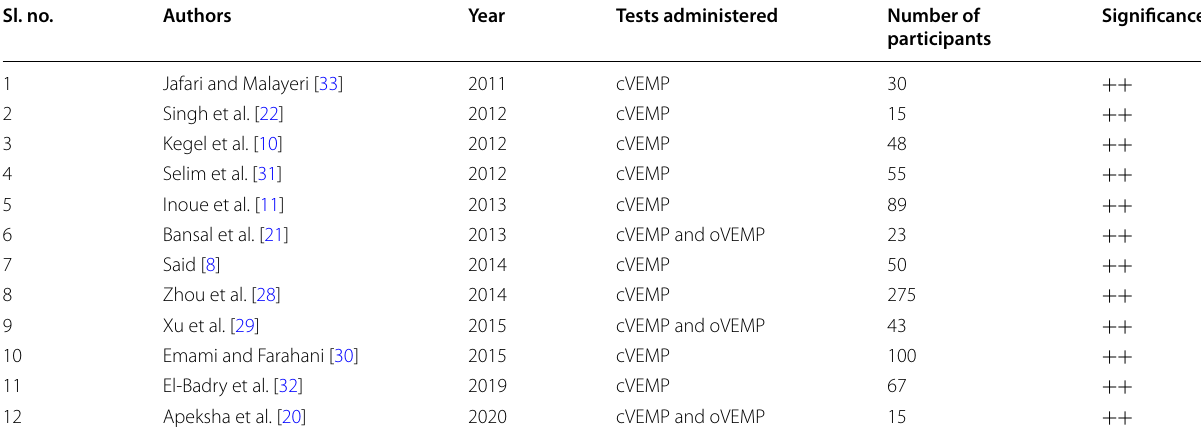
significant difference in any of the cVEMP/oVEMP test parameters between the children with normal hearing and with SNHL ++